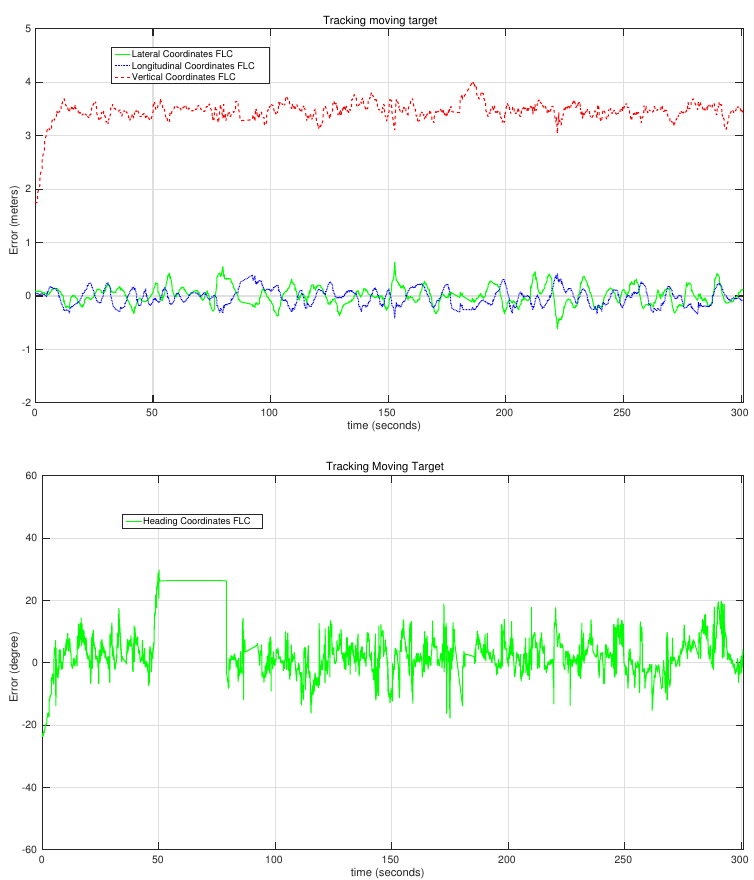
Figure 18. Evolution of the error of the lateral, longitudinal, vertical and heading controllers on the first moving target-following